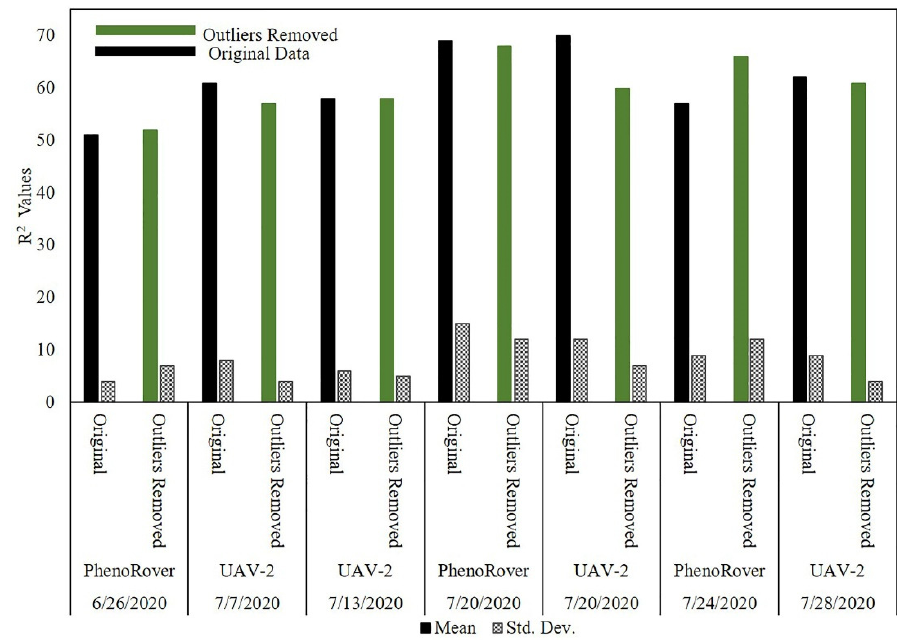
Figure 22. Estimates of LAI for original data and after PointCleanNet-based outlier removal from data acquired by the UAV and PhenoRover.